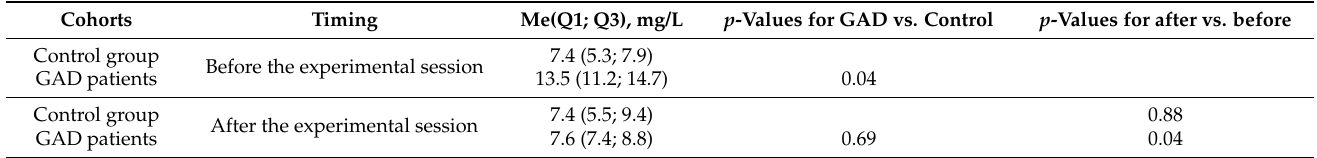
Table 7. Concentration of salivary magnesium in the